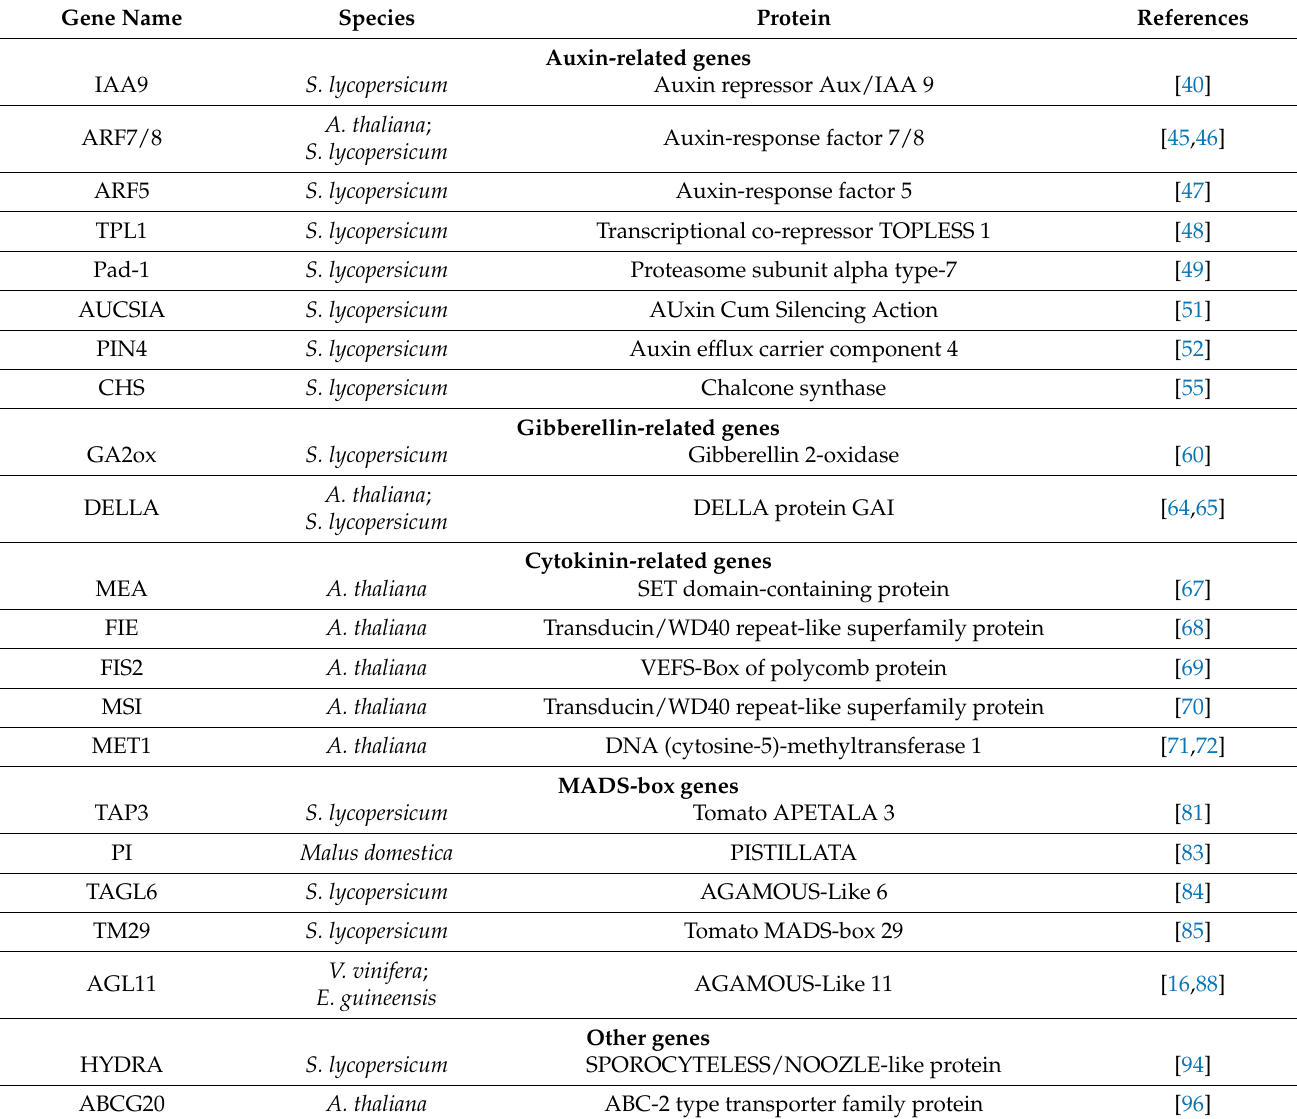
Table 1. Transcription factor genes involved in seed formation could be utilized to induce